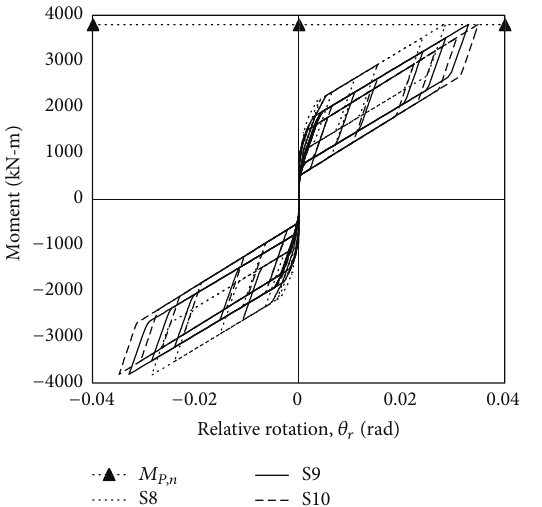
Figure 9: Moment-relative rotation response specimens S8, S9, and S10.